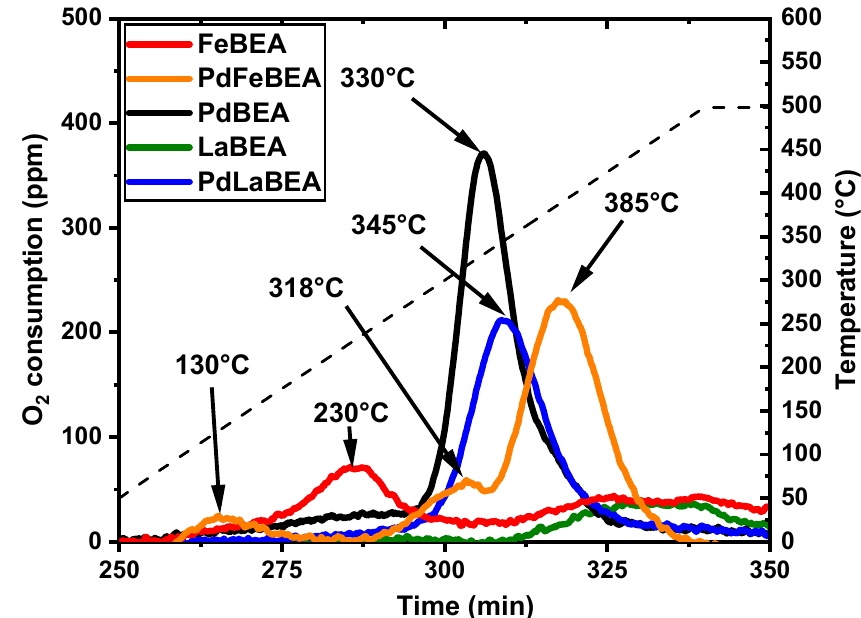
Figure 1. Oxygen consumption for the samples (solid lines) during temperature-programmed oxidation plotted versus time. The corresponding temperature profile (dashed line) is also given.